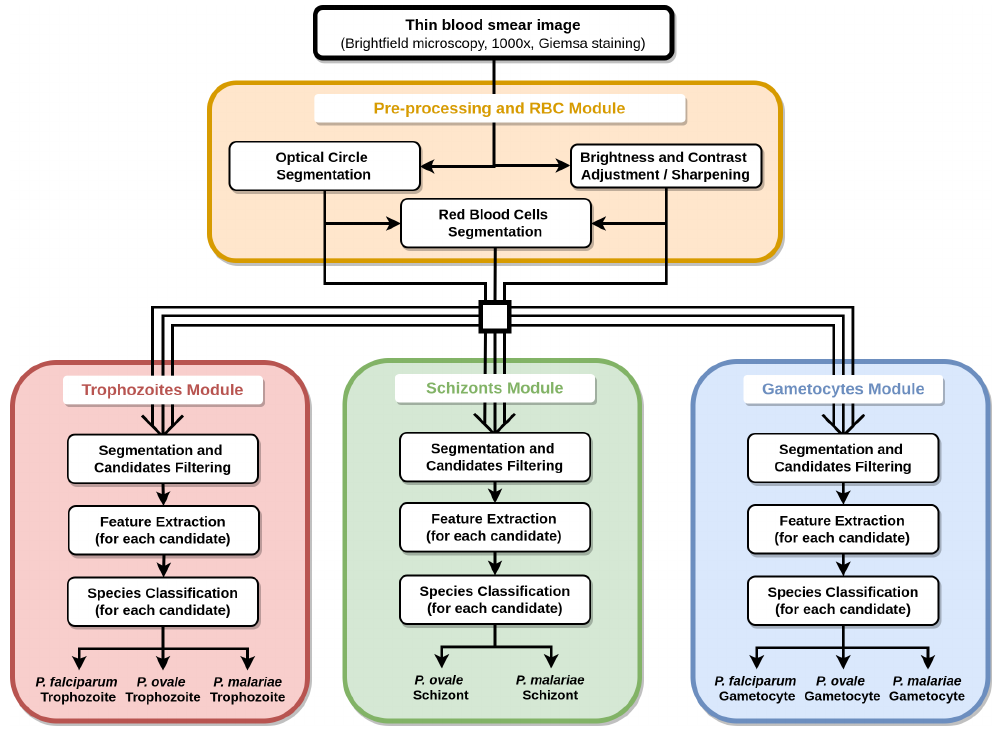
Figure 3. Diagram of the proposed methodology for the automatic analysis of thin smear